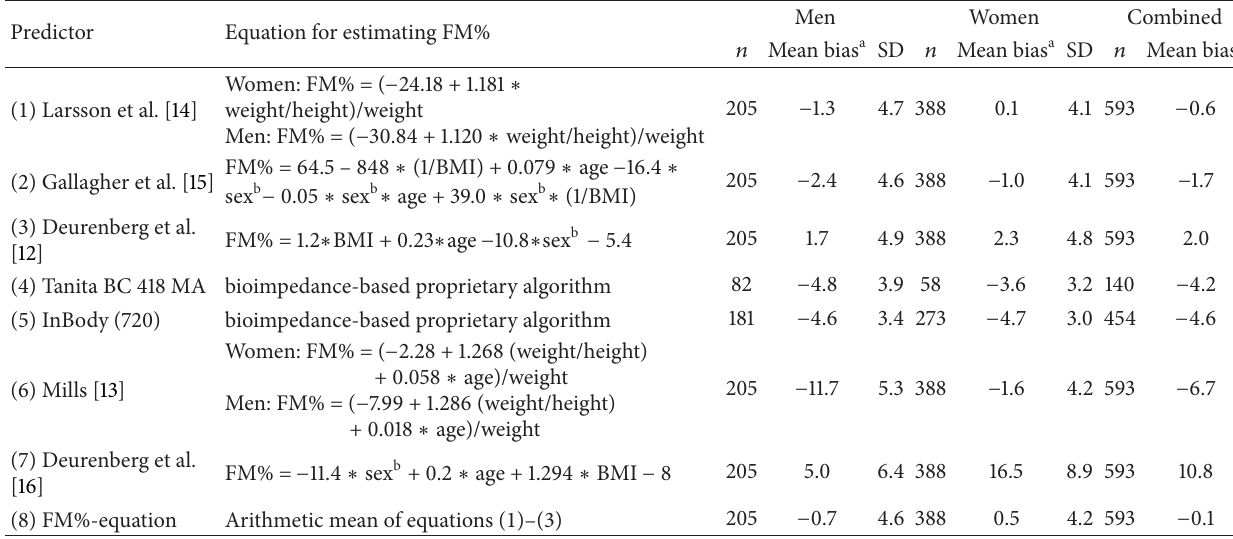
Table 1: Anthropometry- and bioimpedance-analysis- (BIA-) based estimates of fat mass percentage (FM%) and their respective bias versus DXA